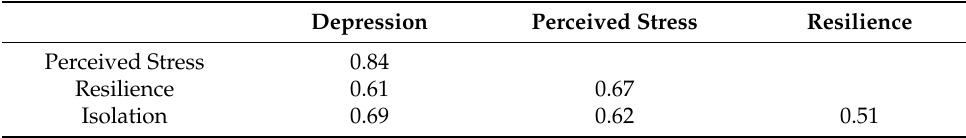
Table 2. Internal consistency/reliability and convergent validity.